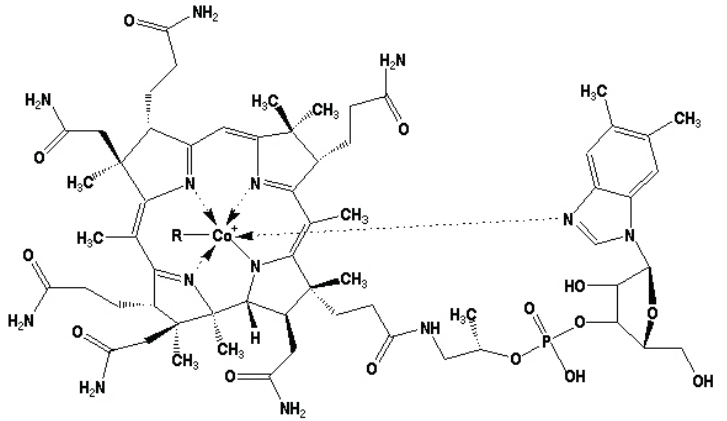
Figure 1. The molecular structure of vitamin B 12 .